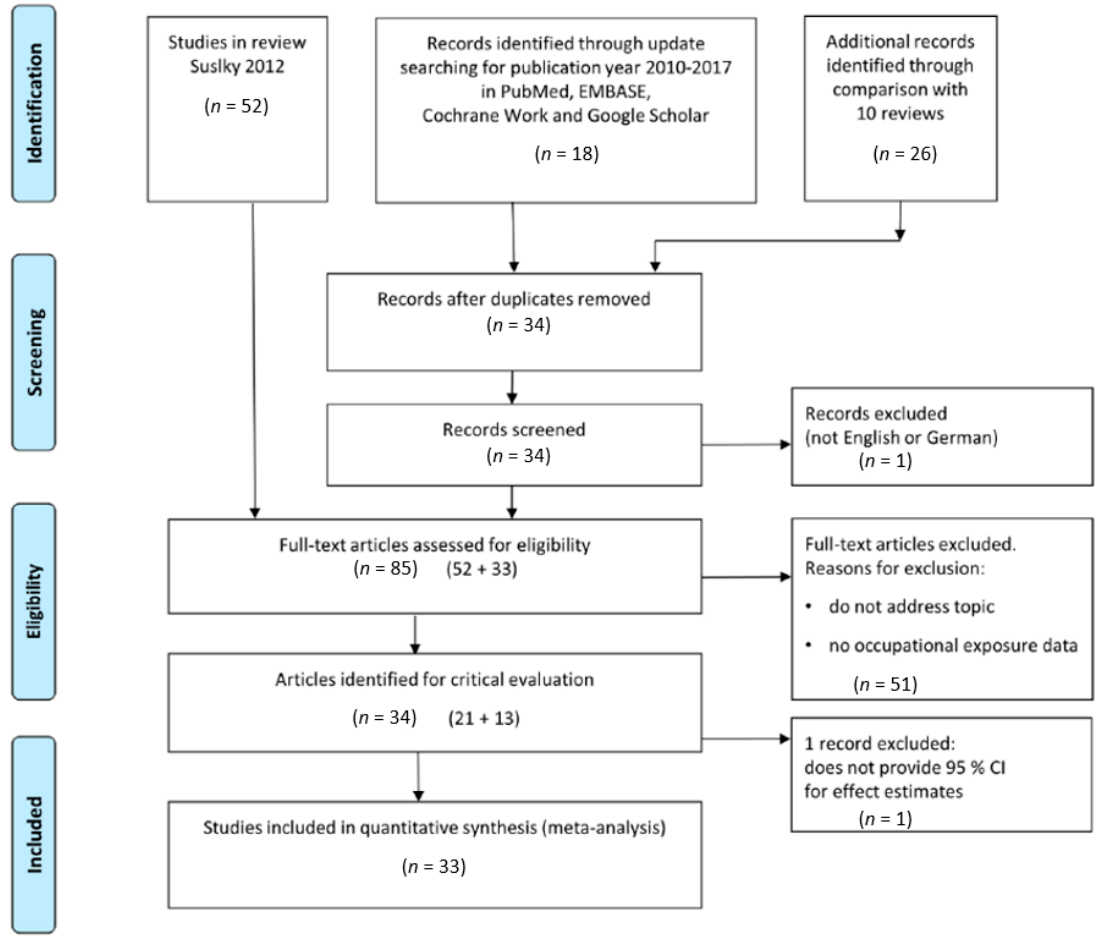
Figure 1. PRISMA (Preferred Reporting Items for Systematic Reviews and Meta-Analyses) flow diagram for the selection of literature for critical evaluation.